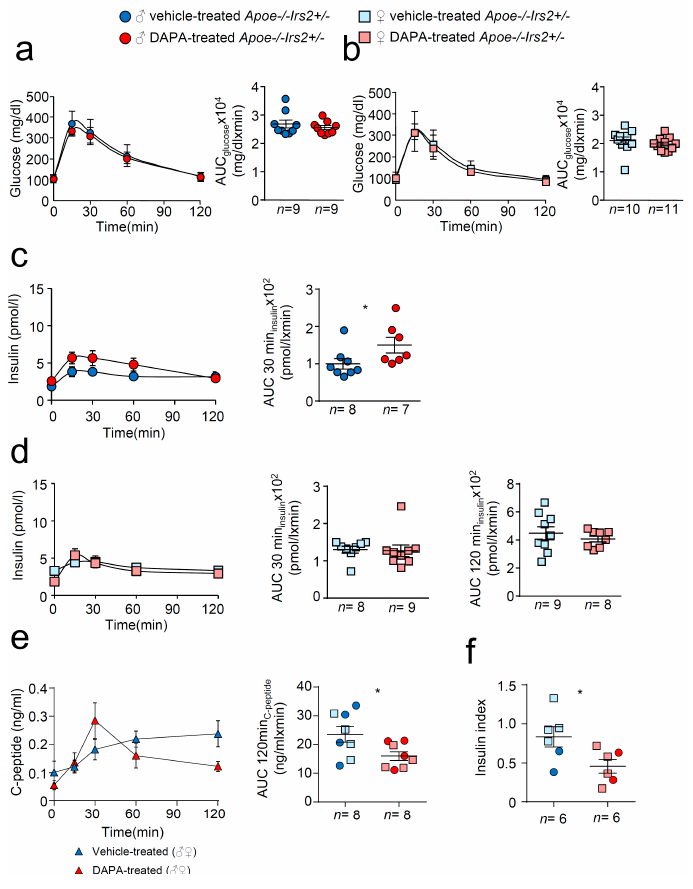
Figure 2. Metabolic characterisation of vehicle-treated and DAPA-treated Apoe − / − Irs2+/ − mice. Glucose levels during the glucose tolerance test (GTT) and the area under the curve (AUC glucose ) generated from the glucose curve during the test for male ( a ) and female ( b ) vehicle- and DAPA-treated mice. Plasmatic insulin levels stimulated by the glucose infusion during the GTT and the AUC insulin calculated at 30 and 120 min of the test for ( c ) male and ( d ) female vehicle- and DAPA-treated mice. ( e ) C-peptide levels during the insulin tolerance test (ITT) and the corresponding AUC c-peptide in 4-hour-fasted mice. ( f ) Insulin secretion index obtained from the glucose-stimulated insulin secretion assay in isolated islets from Apoe − / − Irs2+/ − mice treated with DAPA or vehicle. The statistical analysis for normal distribution was D’Agostino–Pearson ( a – f ) and Kolmogorov–Smirnov test ( f ) and for di ff erences Student’s t -test ( d , right panel) and ( e , f ) and Mann–Whitney U test ( a – d , left panel) ( a – c ) and ( d , left panel). * p <